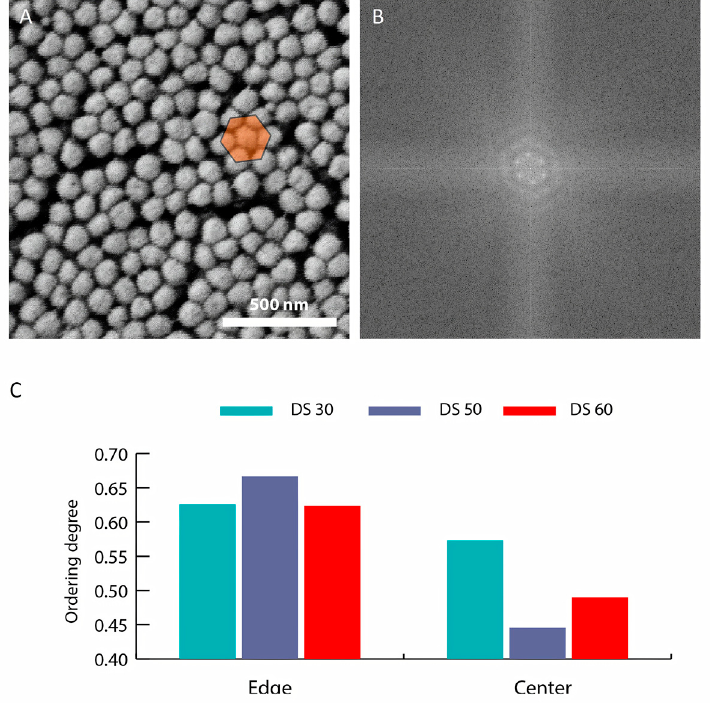
Figure 4. ( A ) The SEM image of the sample. ( B ) The Fourier transform of the ordered PSS. ( C ) The histogram of the distribution of the degree of ordering at the edges of and in the center of the printed structures, depending on the DS.